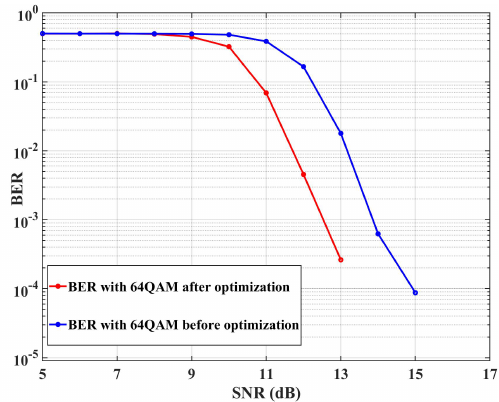
Figure 8. The BER performance of the DCO-OFDM system in the IIoT